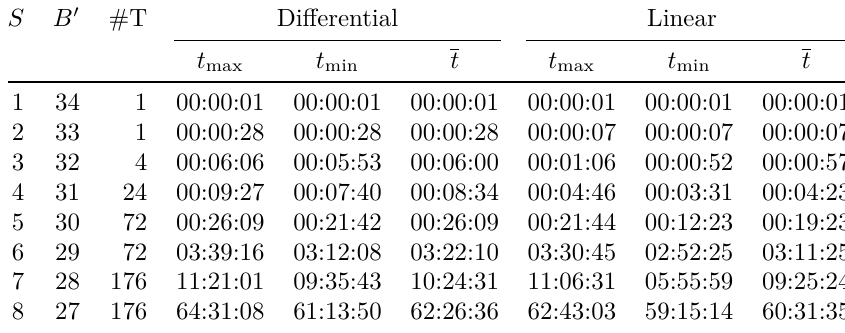
Table 6: Runtime overview for the R 0 = 3-round tests over all girdle patterns of weight S in round 1 or 3 with ≤ B 0 active S-boxes, P = 4. #T is the number of CPU cores used in parallel for the Kissat solver, mostly Intel Xeon E5-2669 or E5-4669 v4 @ 2.20GHz . S B 0 #T Differential